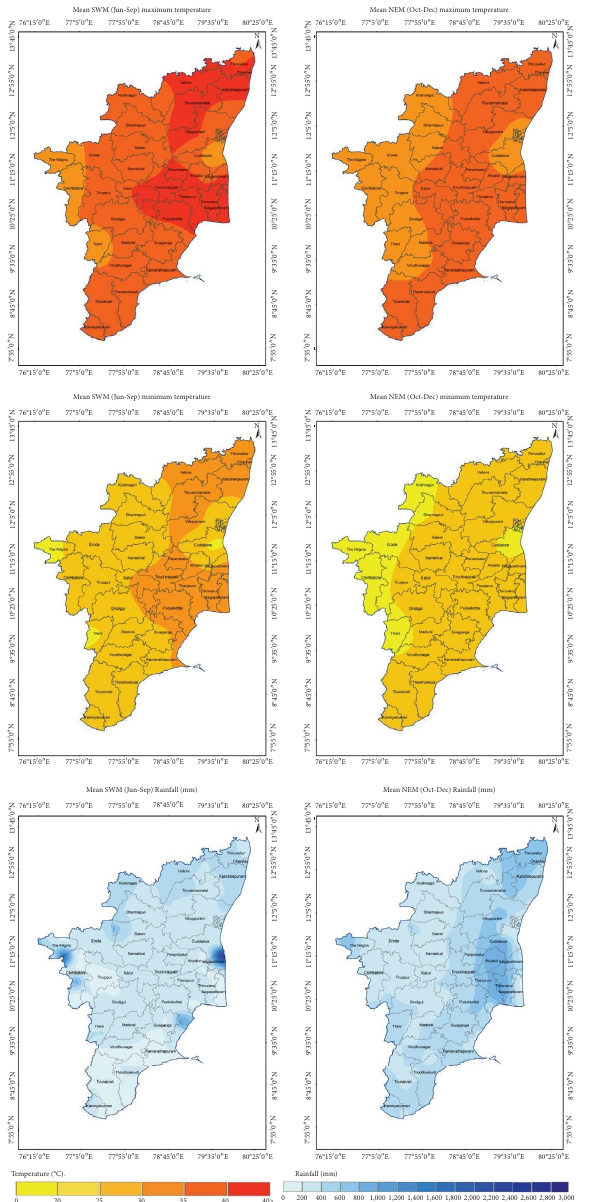
Figure 2: Spatial variation of maximum and minimum temper- atures ( ° C) and rainfall (mm) over Tamil Nadu (mean of 1981–2020). during SWM, with RCP 4.5, the lowest increase in minimum temperature was projected over Ariyalur (1.0 ° C), while the highest increase was projected over Krishnagiri (1.8 ° C), and with RCP 8.5, an increase of 1.9 ° C (Tanjavur) to 2.6 ° C (Perambalur) is projected during the midcentury. As far as NEM is concerned, increase in minimum temperature projected for RCP 4.5 ranges from a lowest value in Tanjavur (1.4 ° C) to a highest value in Perambalur (2.3 ° C), and for RCP 8.5 scenario, the projected increase is from 1.9 ° C (Kanyakumari) to 2.5 ° C (Krishnagiri, Perambalur, and Tiruvallur).